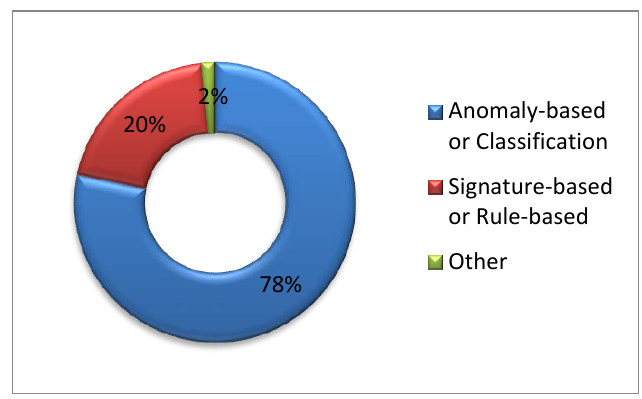
Figure 8. Detection methodology.